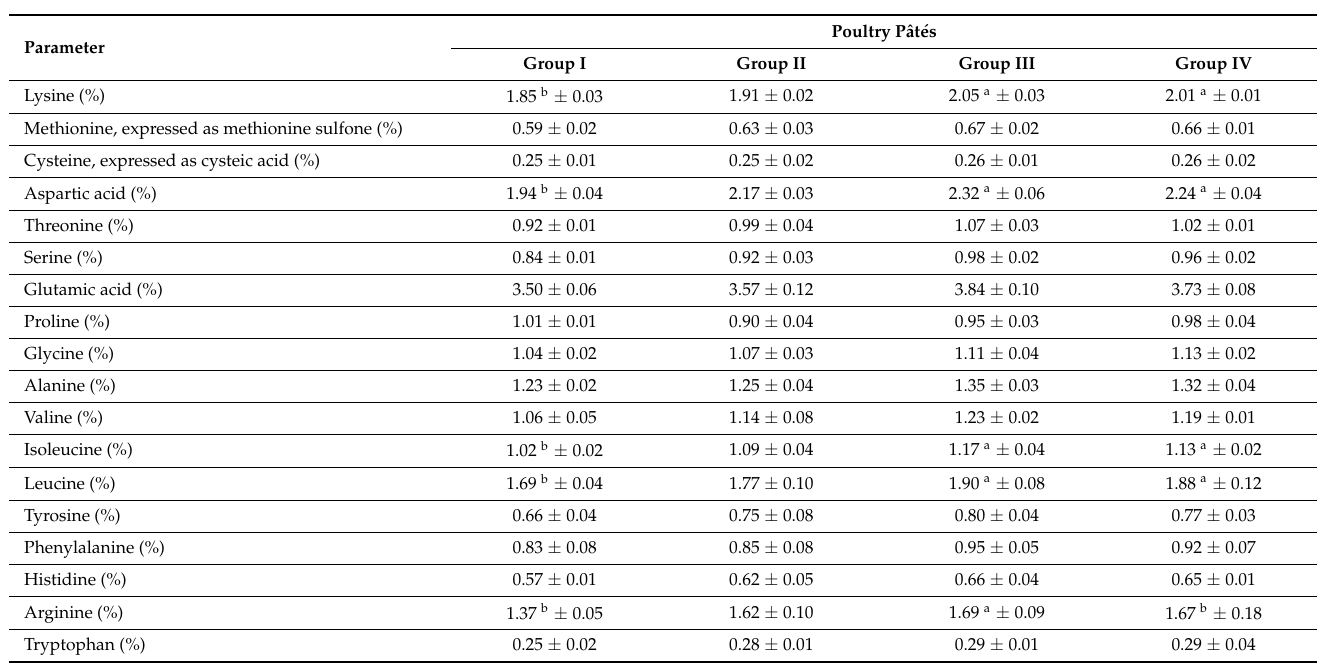
Table 4. Effect of the addition of hemp seeds, amaranth and golden flaxseed on the amino acid ¯ content of poultry p â t é s ( x ±